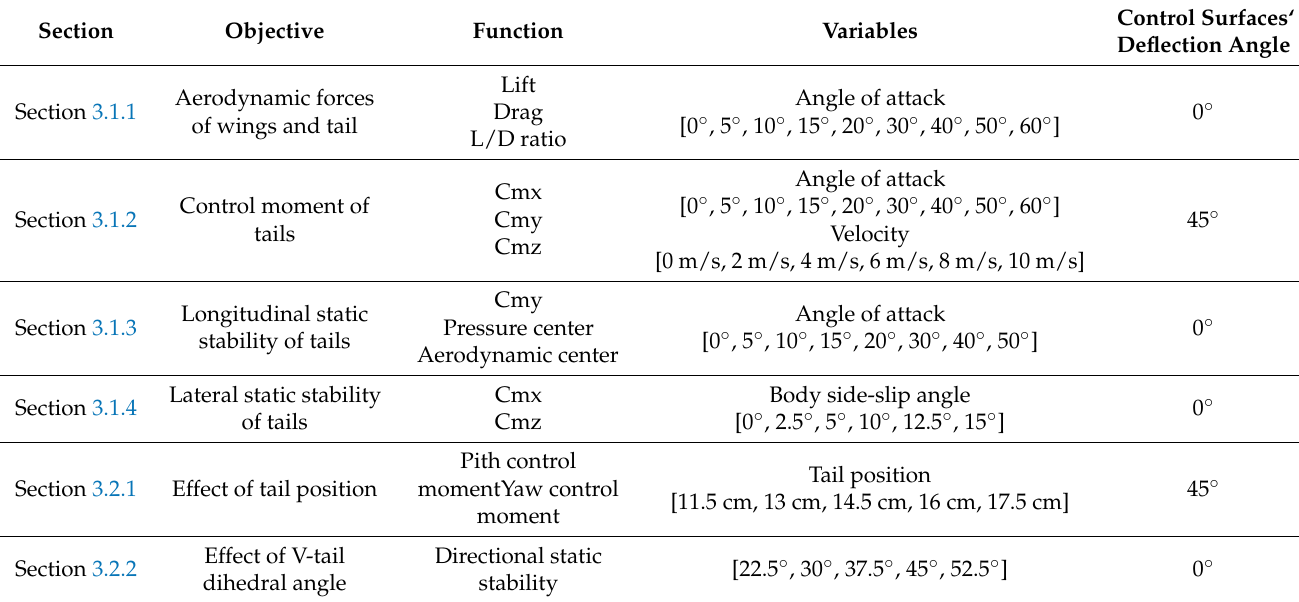
Table 4. Simulation conditions and research objectives.